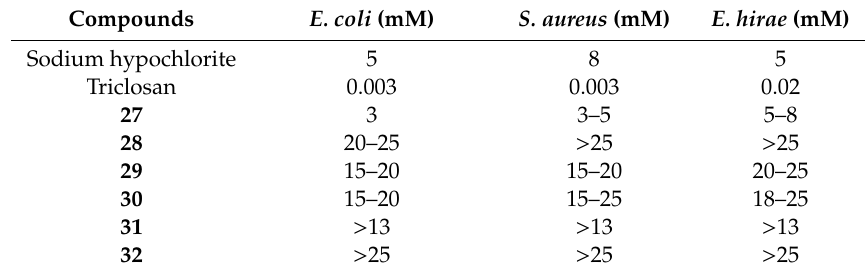
Table 3. Minimum inhibitory concentration (MIC) of representative biocides and derivatives against E. coli, S. aureus and E. hirae [16].